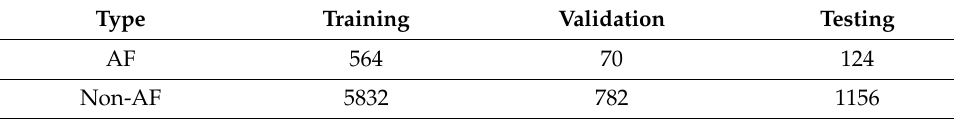
Table 2. Number of recordings for AF patients and non-AF